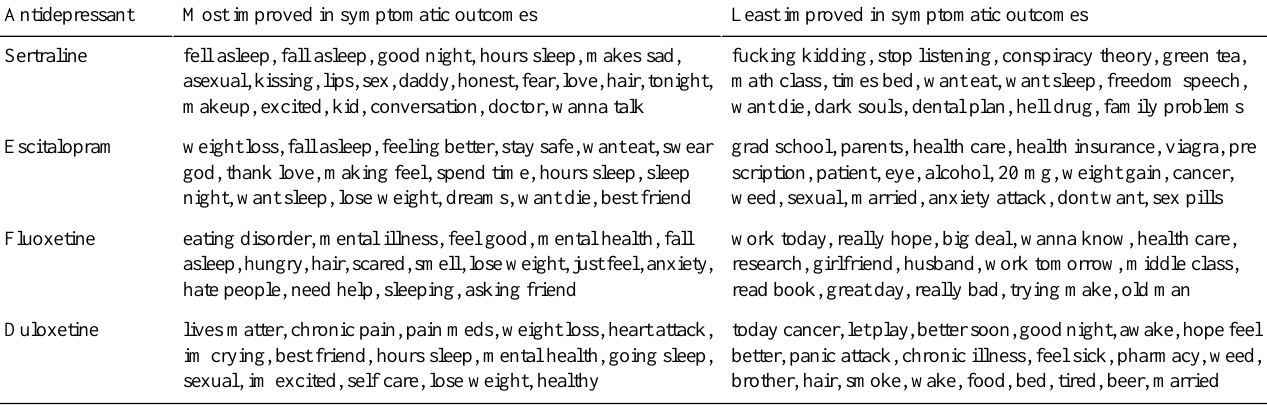
Table 1. Top keywords extracted by SAGE [29] in the most and least improved strata of the 4 most popular antidepressants. Improvement is measured in terms of relative treatment effect on strata of similar users based on changes in mental health symptomatic outcomes of depression, anxiety, stress, suicidal ideation, and psychosis.